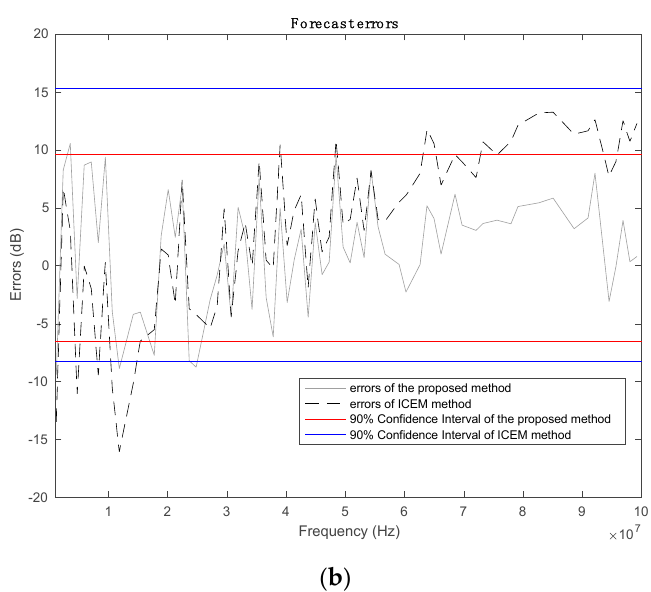
Figure 23. Comparison between the proposed method and ICEM method for Board 2. ( a ) Predicted results; ( b ) forecast errors.